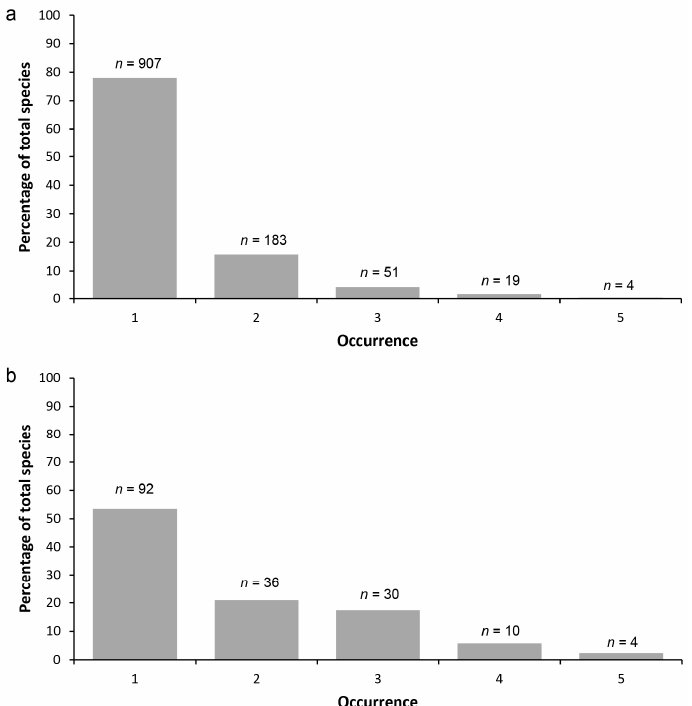
Figure 3. Proportions of sponge species shared between IMCRA bioregions. Bars represent percentages of species occurring in 1, 2, 3, 4 or 5 of the IMCRA bioregions at the level of A) combined described species and OTUs ( n = 1164) and B) described species only ( n = 172). Numbers above each bar represent actual frequencies of species. For example, 4 species occurred in 5 bioregions. No species occurred in all six bioregions.